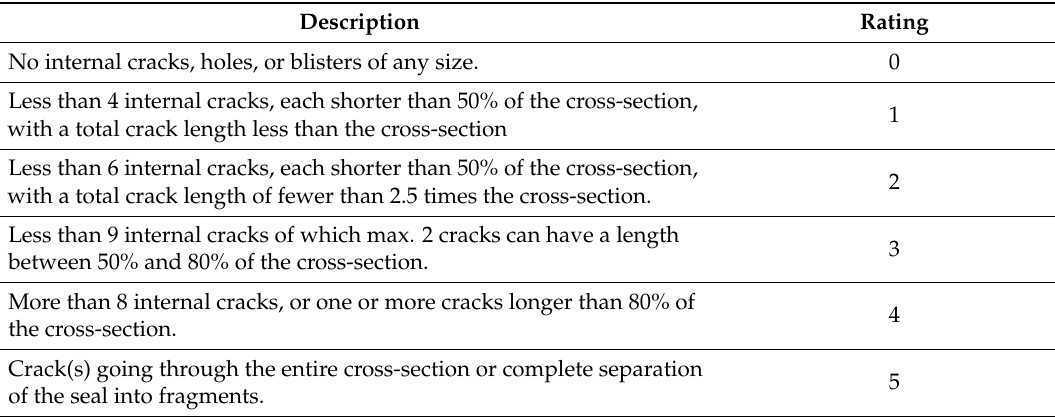
Table 2. The seal-failure rating criteria according to NORSOK testing standard [30]. Description